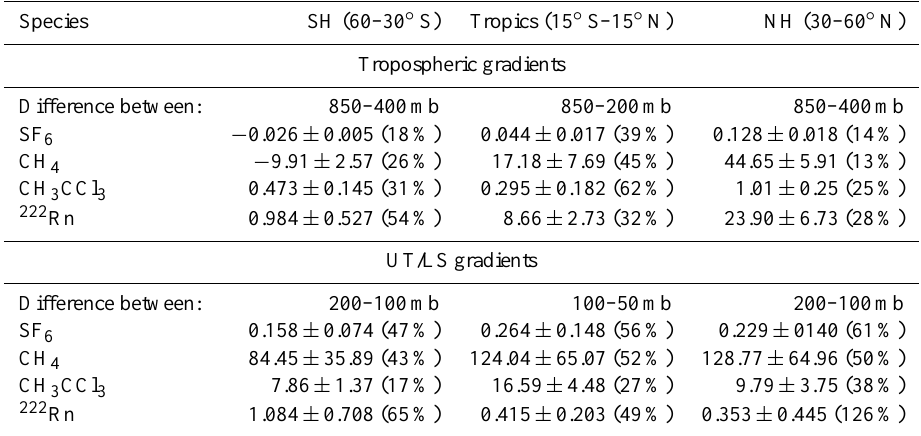
Table 3. Multi-model averages ( ± 1 σ ; and between model variability defined by 1 σ /average, within parenthesis in %) of simulated SF 6 (ppt), CH 4 CTL (ppb), CH 3 CCl 3 (ppt) and 222 Rn( × 10 − 21 ) gradients in the troposphere and UT/LS region for three broad latitude bands, namely, the SH midlatitude, tropics and NH midlatitude.